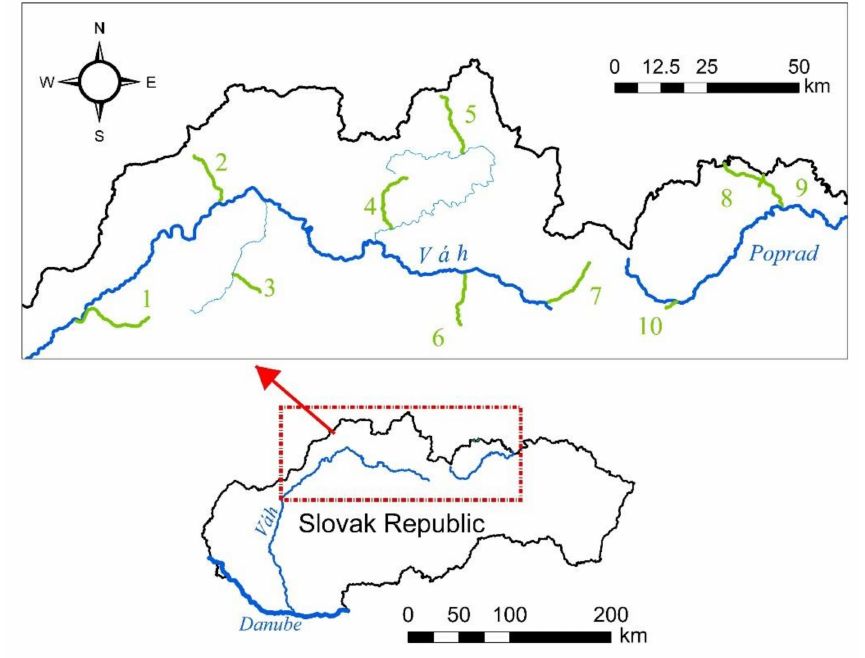
Figure 1. Localization of the reference reaches of the mountain streams in